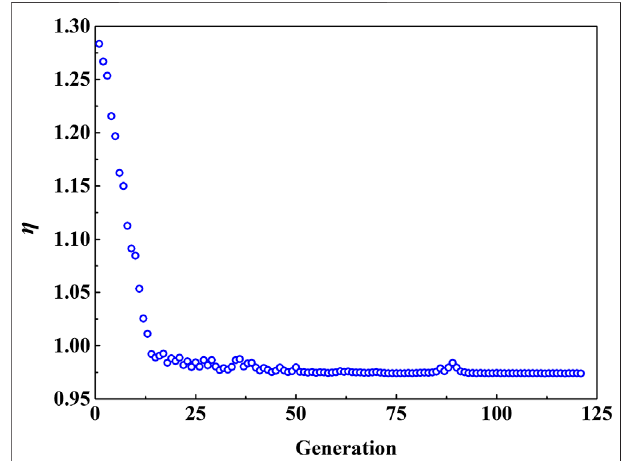
FIGURE 5 | Changes of cracking risk coef fi cient with evolution